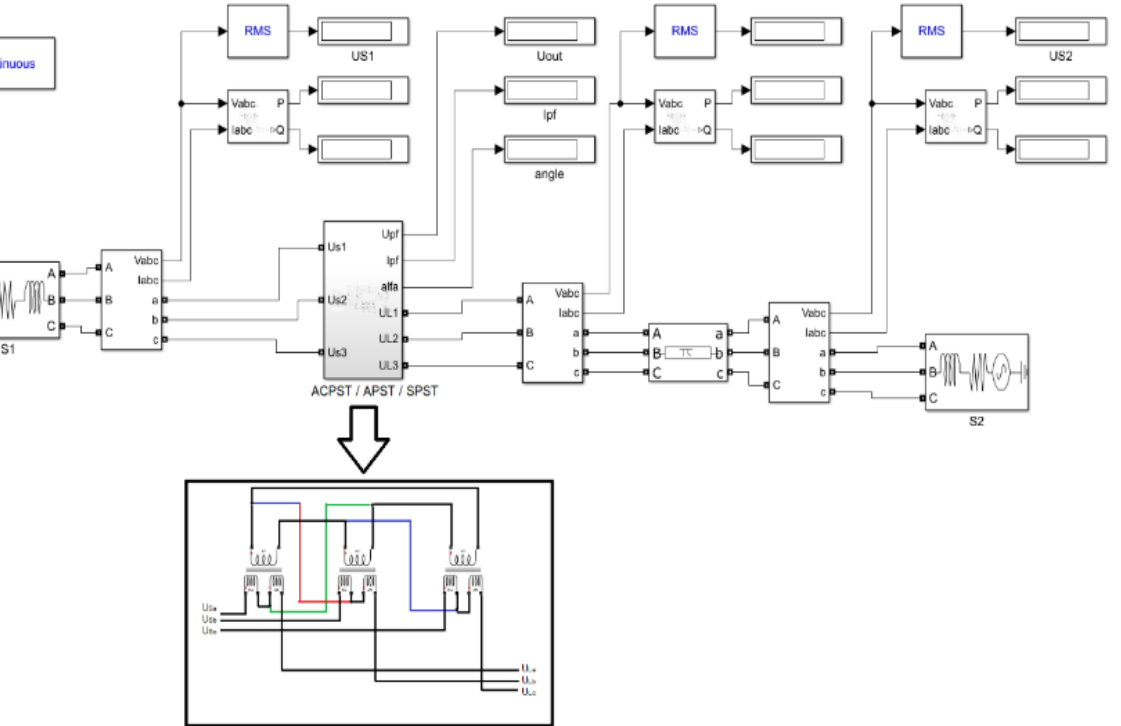
Figure 9. The Simulink connection scheme for simulation tests of ACPST, APST, and SPST